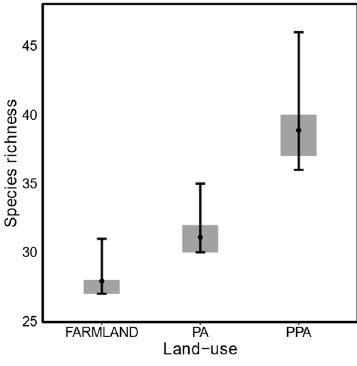
Figure 2. Estimated mammalian (>0.5 kg) species richness in the small-livestock farmland (Farmland), protected area (PA), and private protected area (PPA) (black dots: mean, grey boxes: 50% BCI, and black bars: 95% BCI).